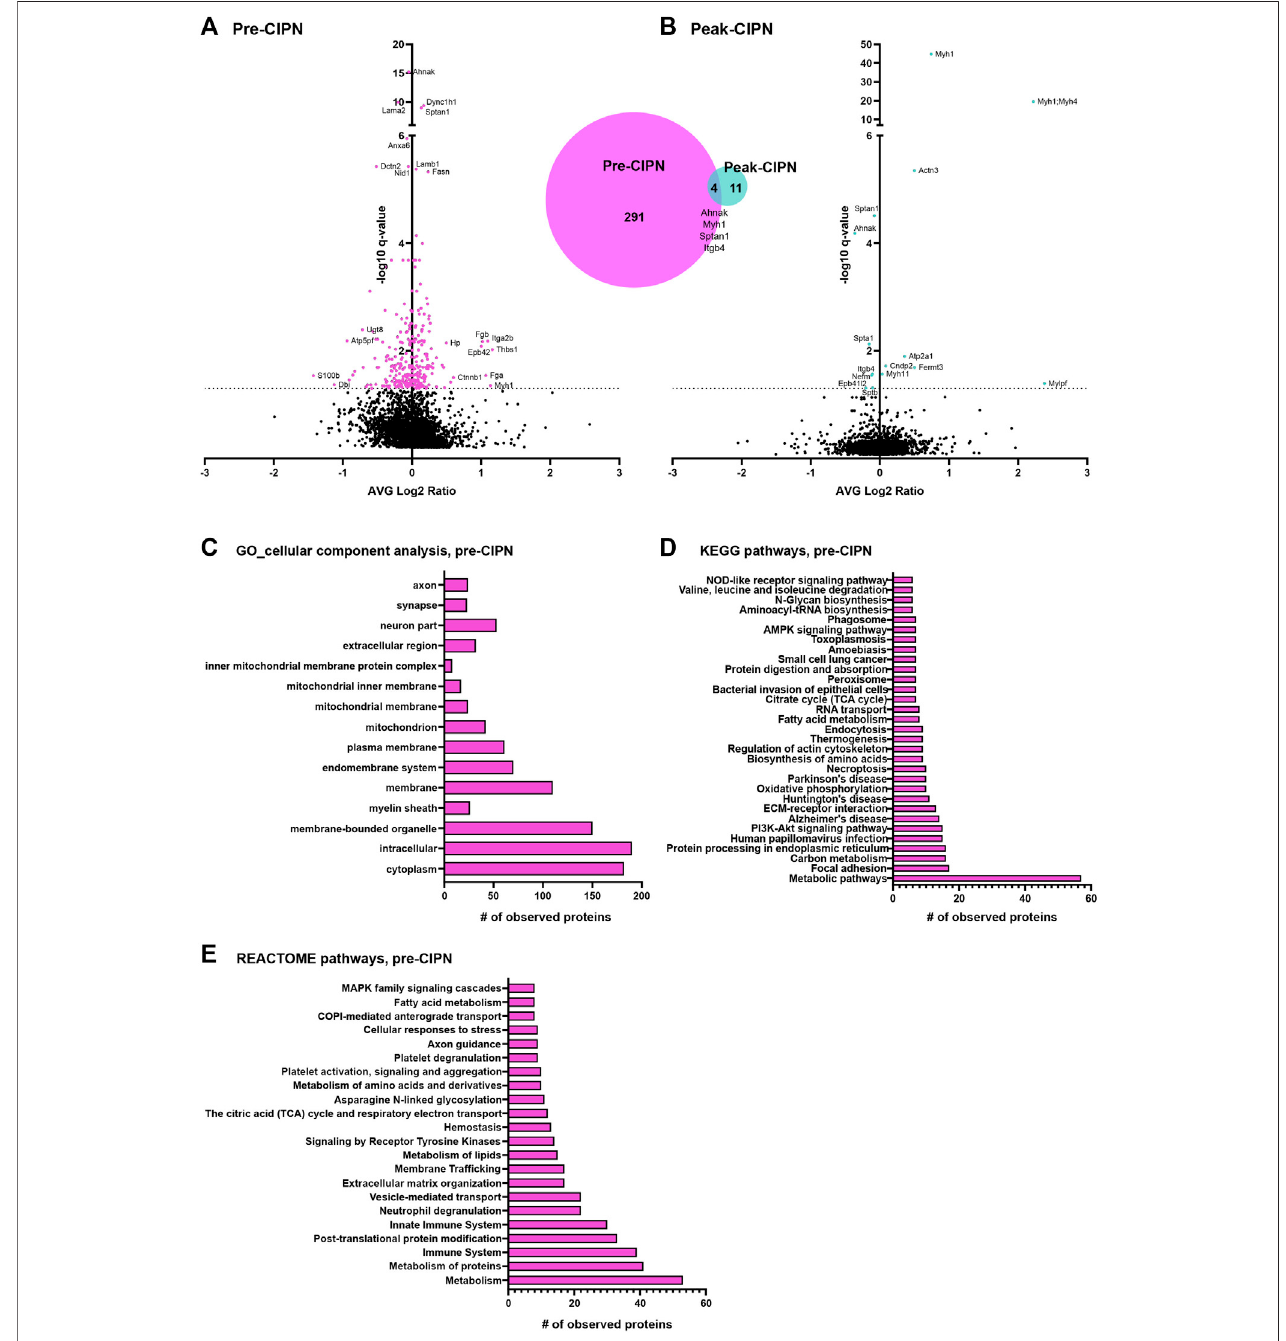
FIGURE3| DRGproteinsignaturefollowingpaclitaxeltreatmentpriorto(pre-CIPN)andduring(peak-CIPN)neuropathy. (A) TheVolcanoplotdisplaystheaveragelog2fold change (log2 pre-CIPN/vehicle) of detected proteins and corresponding -log10 of q-values. 295 out of a total of 3,228 quanti fi ed proteins were signi fi cantly regulated (magenta- colored circles above the dotted horizontal line, which represents q < 0.05; q = BH-adjusted p-value) following paclitaxel treatment at pre-CIPN time point compared to vehicle treatment.ThenumbersaresummarizedintheVenndiagram.Examplesofregulatedproteinsaregiven,yet,forclarityandconsistencywithinthemanuscript,genenames areused. (B) Thevolcanoplotdisplaystheaveragelog2foldchange(log2peak-CIPN/vehicle)ofdetectedproteinsandcorresponding-log10ofq-values.15outofatotalof3,224 quanti fi ed proteins were signi fi cantly regulated (cyan-colored circles above the dotted horizontal line, which represents q < 0.05; q = BH-adjusted p-value) following paclitaxel treatmentatpeak-CIPNtimepointcomparedtovehicletreatment. (C) Atpre-CIPNregulatedproteinsarelocalizedtodiversecellularcomponentsasassessedbygeneontology (GO) analysis. (D, E) At pre-CIPN, regulated proteins are associated with diverse KEGG (D) and REACTOME (E) pathways. Only annotated pathways, which exhibit signi fi cant enrichment (FDR < 0.05; assessed via the web-based interface STRING); are reported.